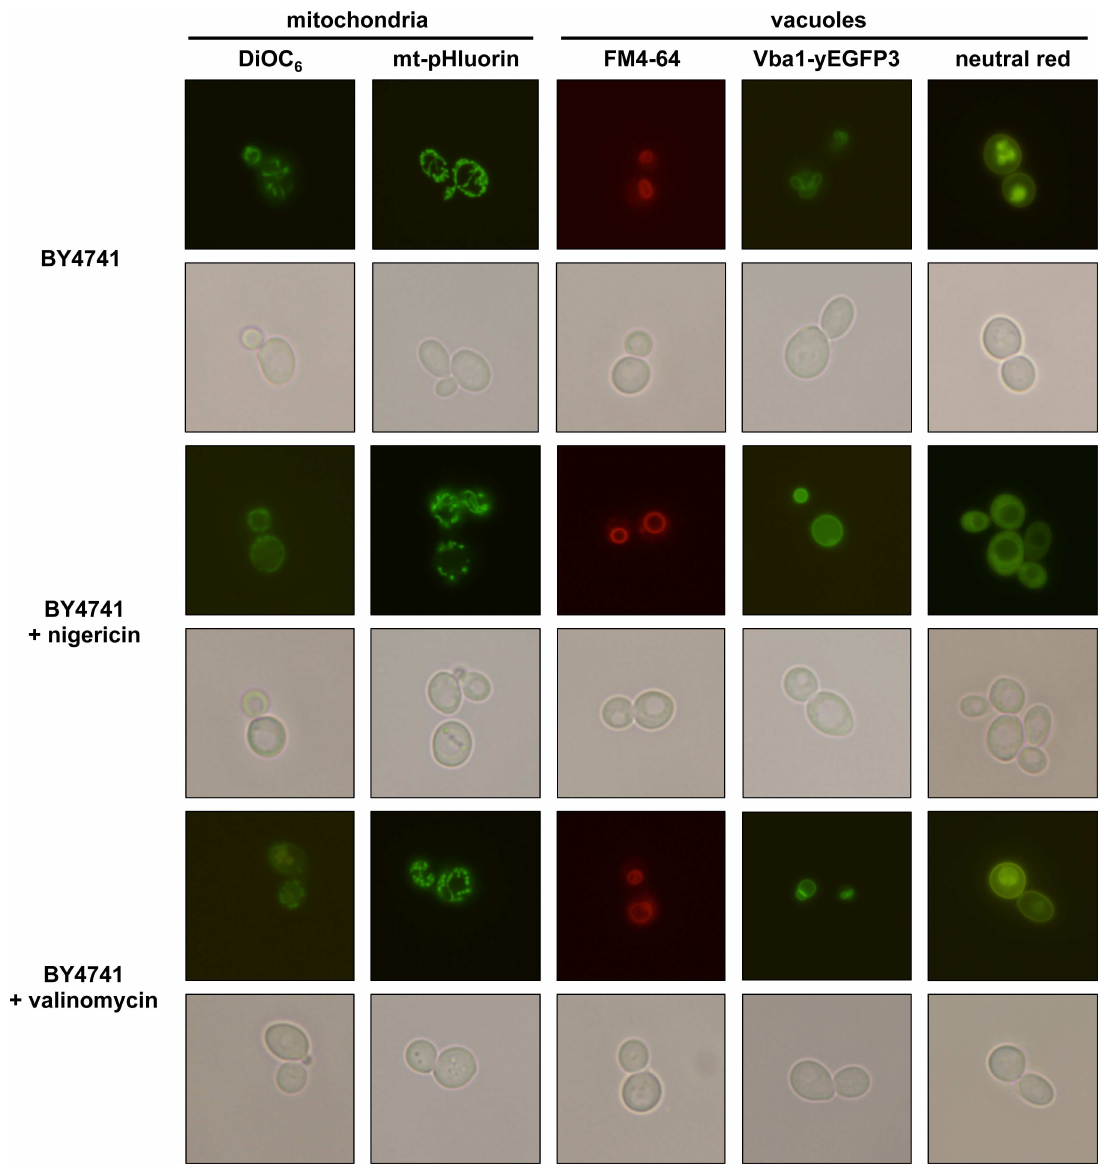
Fig 5. Organelle morphology in yeast cells treated with ionophores. The wild-type strain (BY4741) and the corresponding transformants were cultivated in sSG medium. After addition of nigericin(15 mg/l) or valinomycin(15 mg/l) the cells were observed by fluorescence microscopy. Mitochondria were visualizedusing DiOC 6 or mt-pHluorin (expressed from a plasmid) and vacuoleswere stained with FM4-64, neutral red or Vba1-yEGFP3 (expressed from the plasmid